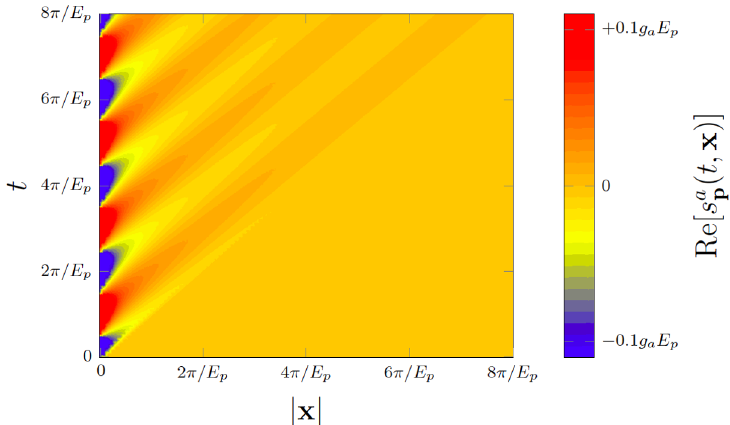
( t, x )] from (3.2) vs t and | x | , showing the wave-front emanating from Figure 4 : Re [ s a p t = x = 0 , the growth for small | x | and the oscillatory behaviour with wavelength set by . (Colour E p